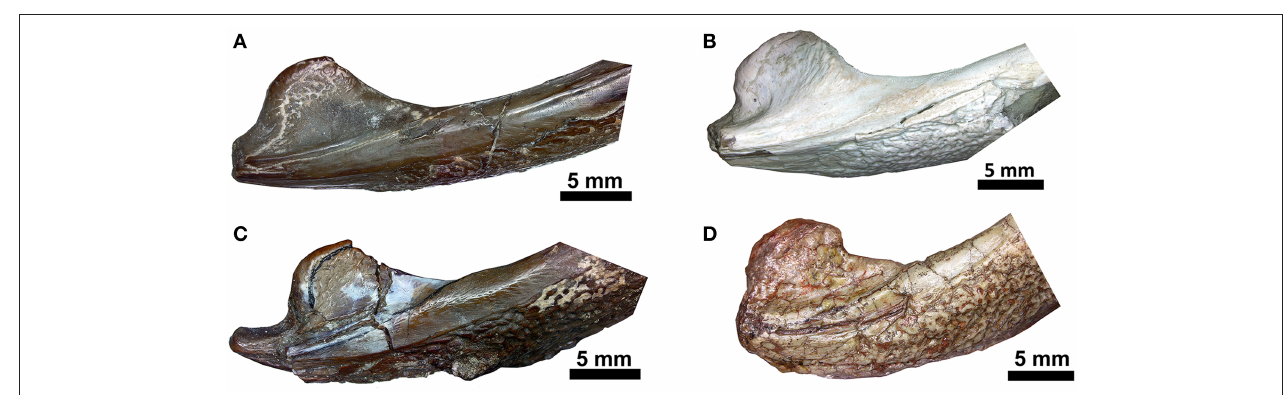
FIGURE 9 | Comparison of the region of the retroarticular process in ventral aspect. (A) Captorhinus kierani (OMNH73281a); (B) Captorhinus magnus (OMNH56821); (C) Captorhinus aguti (OMNH52329); (D) Captorhinus laticeps (FMNH-UC642). Note that to facilitate comparison, images (A,B , D) are flipped horizontally and in life represent the right